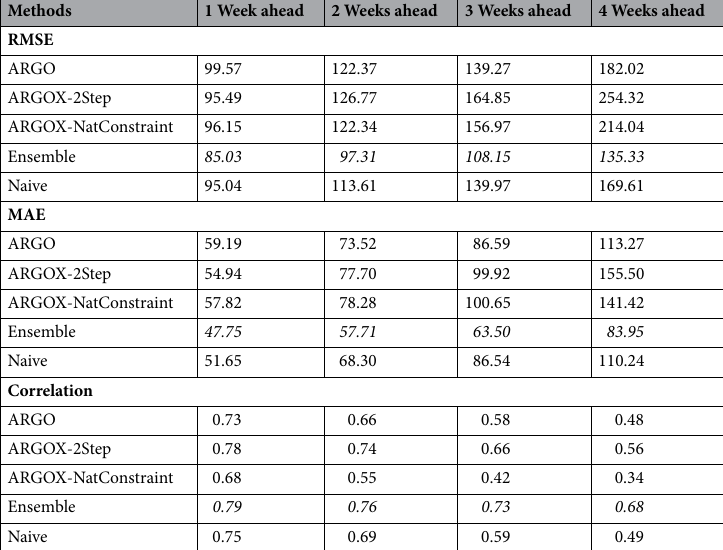
Table 2. Comparison of different methods for state-level COVID-19 1 to 4 weeks ahead incremental death in 51 U.S. states. The averaged RMSE, MAE, and correlation are reported and best performed method is italicized.